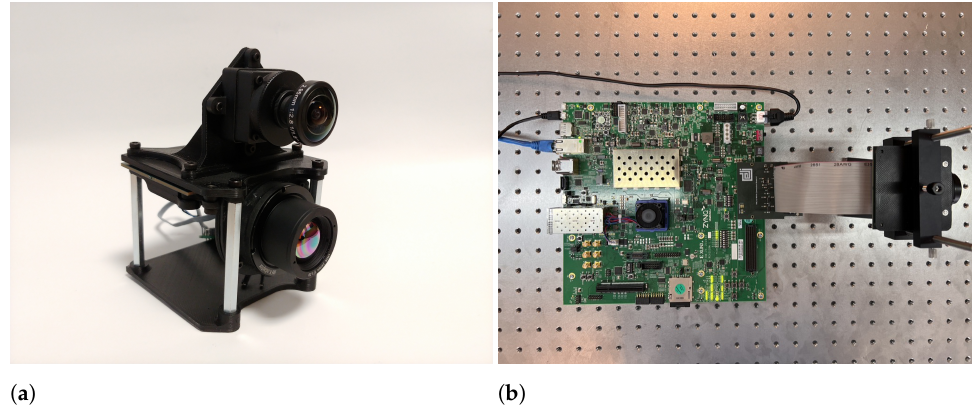
Figure 8. Experimental setup: ( a ) IRFPA and RGB camera fixture, ( b ) ZCU102 evaluation board with FMC extension for camera.